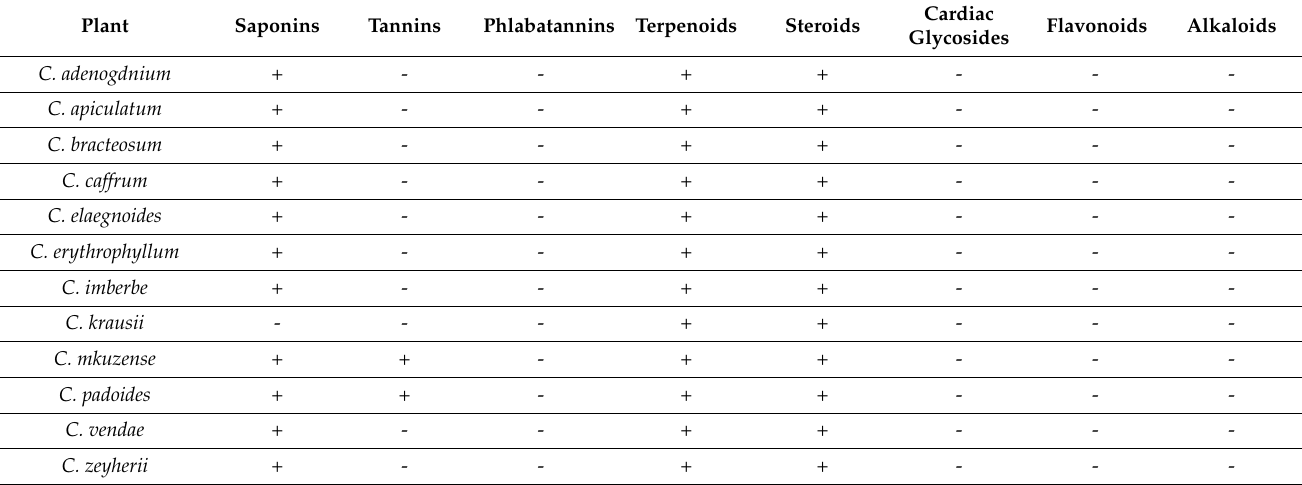
Table 4. Qualitative test for phytochemicals in the ashes of twelve Combretum